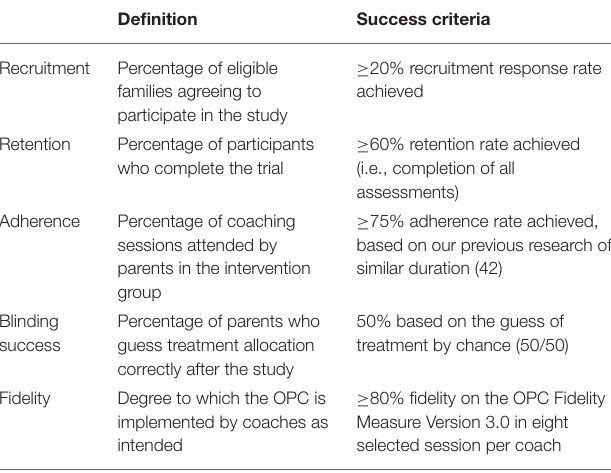
TABLE 2 | A priori success criteria to assess the feasibility of the